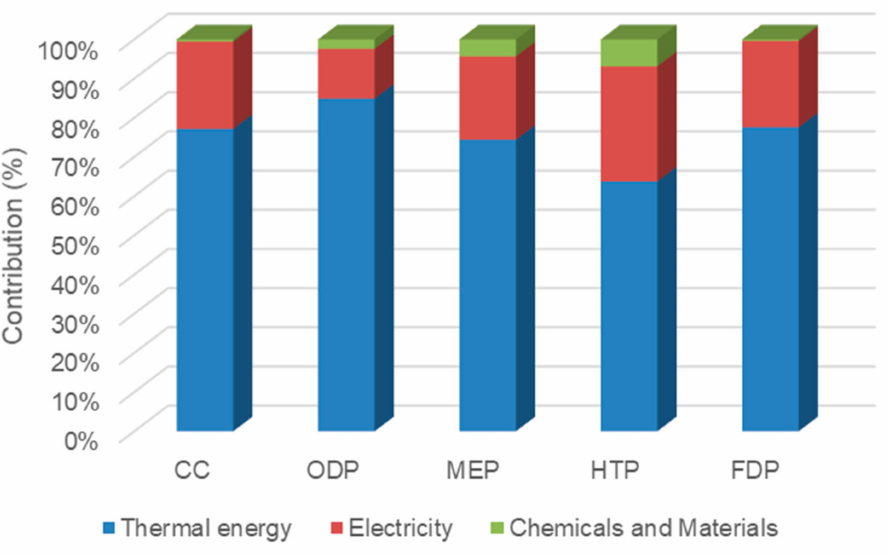
Figure 9. The contribution of inventories in midpoint impacts of case 3.